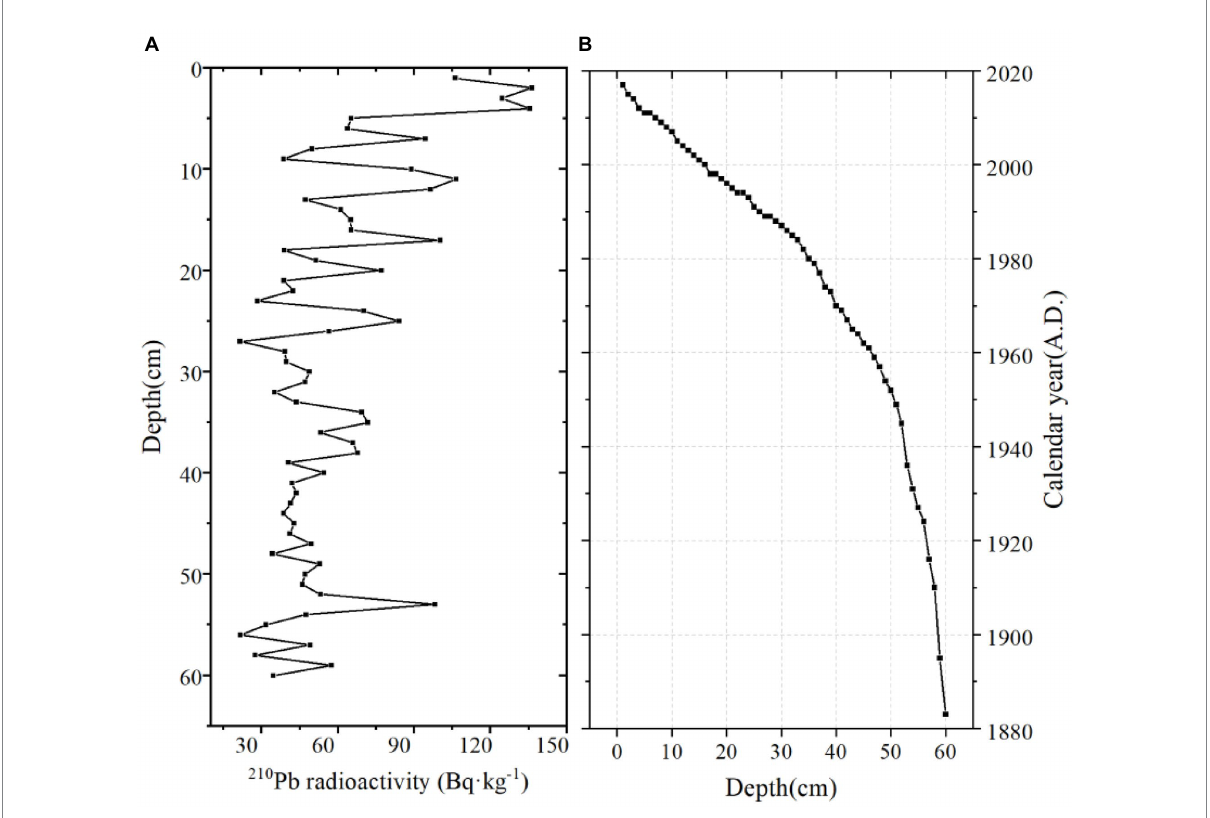
FIGURE 3 Radioactivity results for 210 Pb (A) , and the CRS calculated age (B) , of the JDY peat core in Altay Mountains, NW